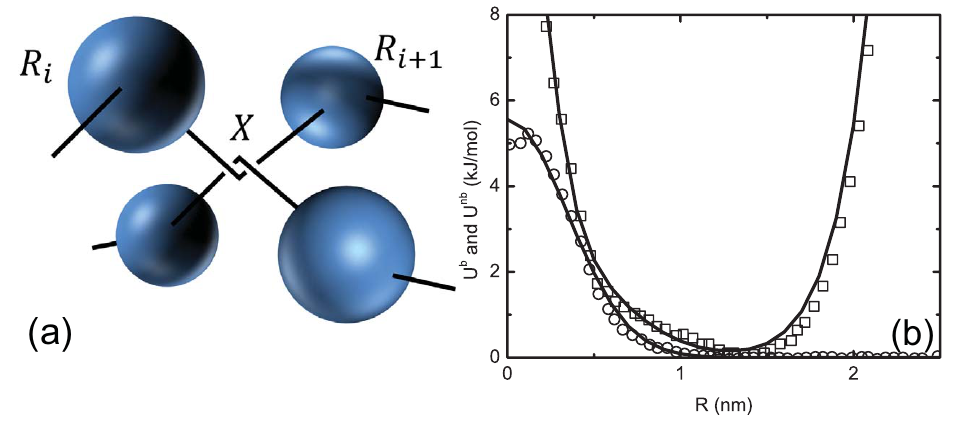
Figure 13. Illustrations for ( a ) the blob model and ( b ) potential functions for bonded ( U b , squares) and non-bonded ( U nb , circles) interactions. In ( b ), the scattered data are taken from [85]. The solid lines are fitted with Equations (13) and